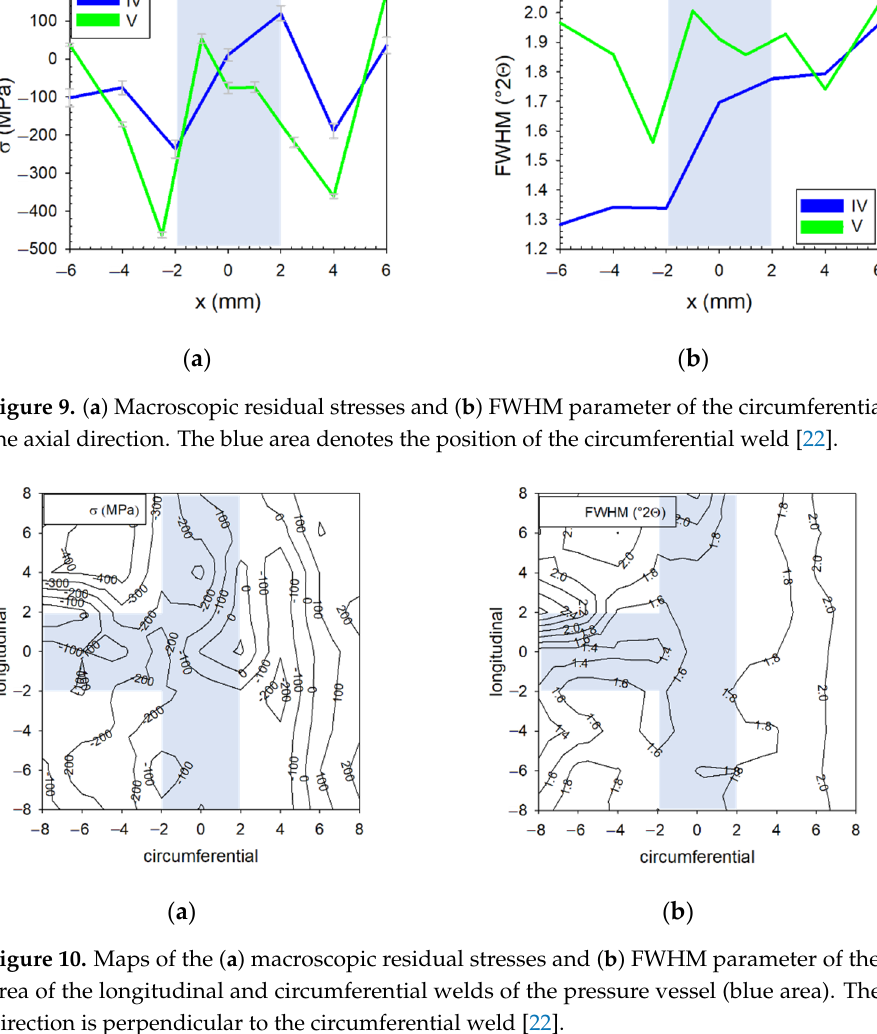
Figure 8. ( a ) Macroscopic residual stresses of the longitudinal weld in the transversal direction and ( b ) macroscopic residual stresses and FWHM parameter of the area I. The blue area denotes the position of the longitudinal weld [22].